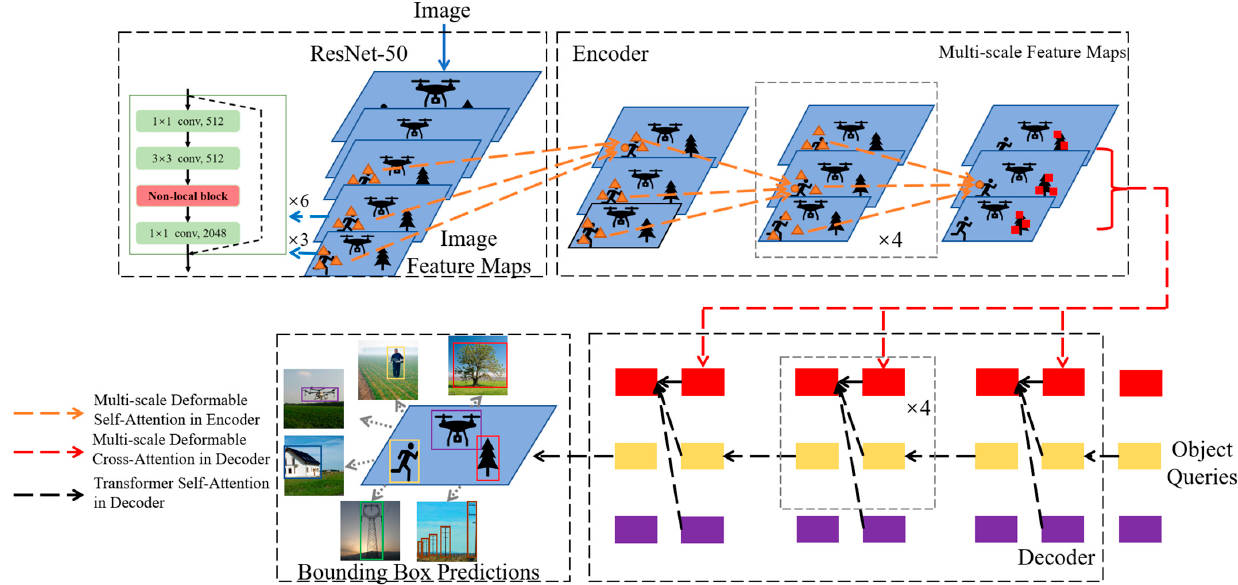
Figure 5. The structure of Non-local Deformable DETR.